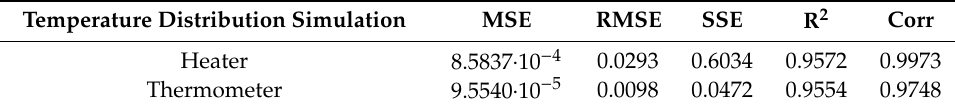
Table 3. Evaluation of goodness of fitting of simulation results to real